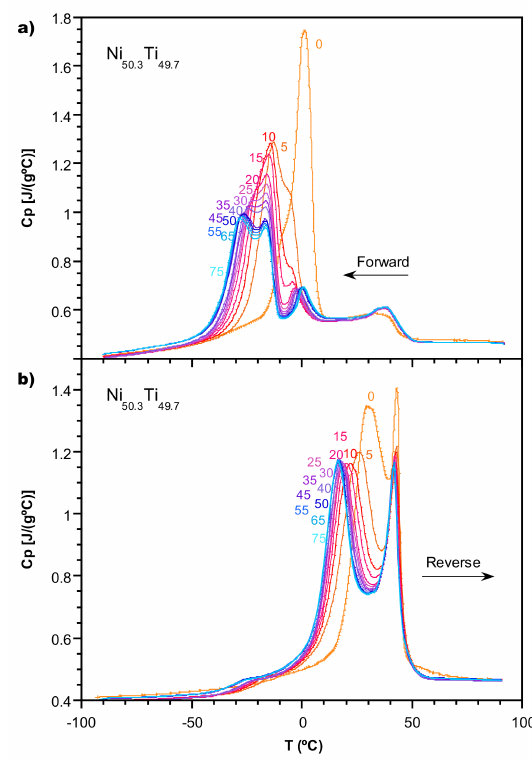
Figure 1. The Ni 50.3 Ti 49.7 specific heat ( C p ) under cycling, showing the evolution of the forward ( a ) and reverse ( b ) martensitic transformations